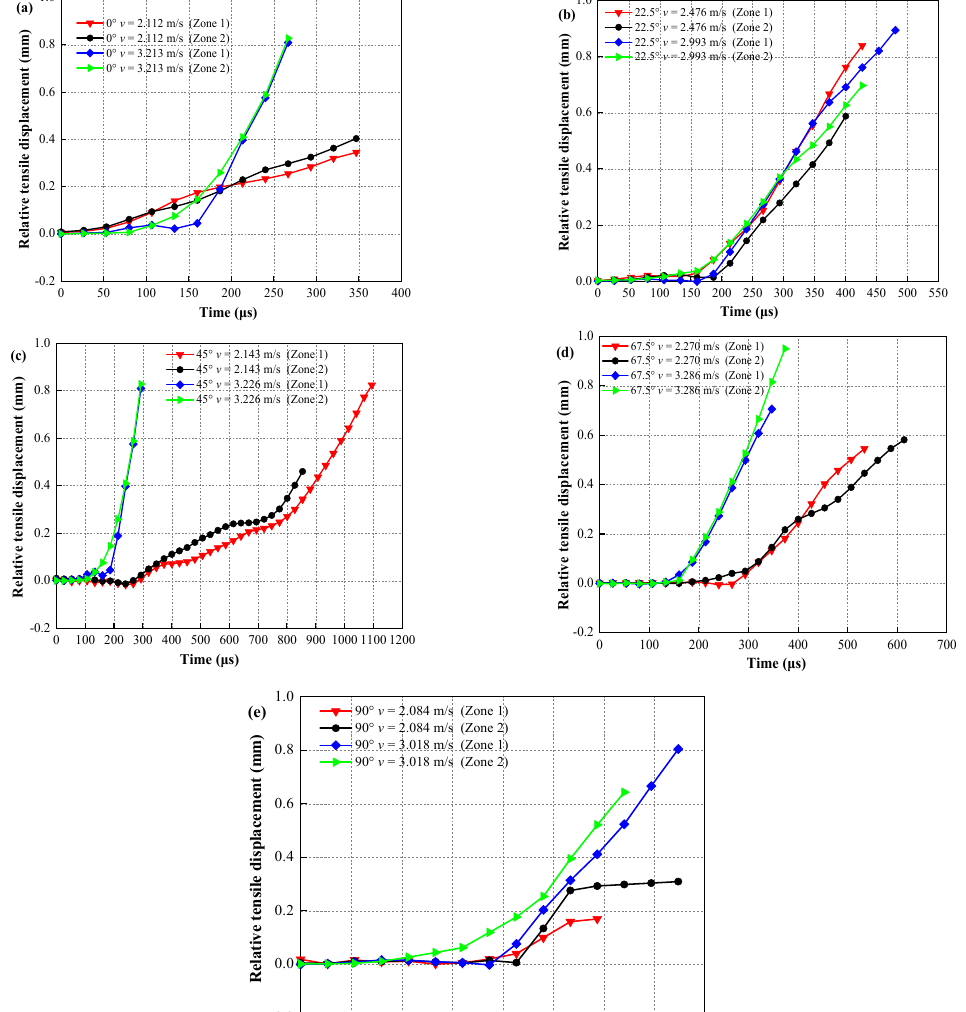
Figure 19. Relative tensile displacement evolution of outburst coal specimens. ( a ) 0°, ( b ) 22.5°, ( c ) 45°, ( d ) 67.5°, ( e ) 90°. It can be seen from Figure 18 that when the bedding orientation was 45°, the peak deformation energy density in area 1 and area 2 of the specimen reached 7000 × 10 6 J/m 3 , which was the largest among the five specimens. When the bedding orientation was 90°, the peak deformation energy density was about 4000 × 10 6 J/m 3 . The time taken for the specimen to reach peak energy was essentially 100–130 μ s. When the peak of the deformation energy density fell ( θ = 0°), the peak deformation energy density differed by a factor of 5–7, influenced by the velocity of the impact load on the specimen. It is speculated that when the bedding orientation is 0°, because the cohe ‐ sion between radial bedding is weak, microcracks would develop rapidly in the coal rock along the bedding surface. However, the microcracks in other areas of the coal rock would